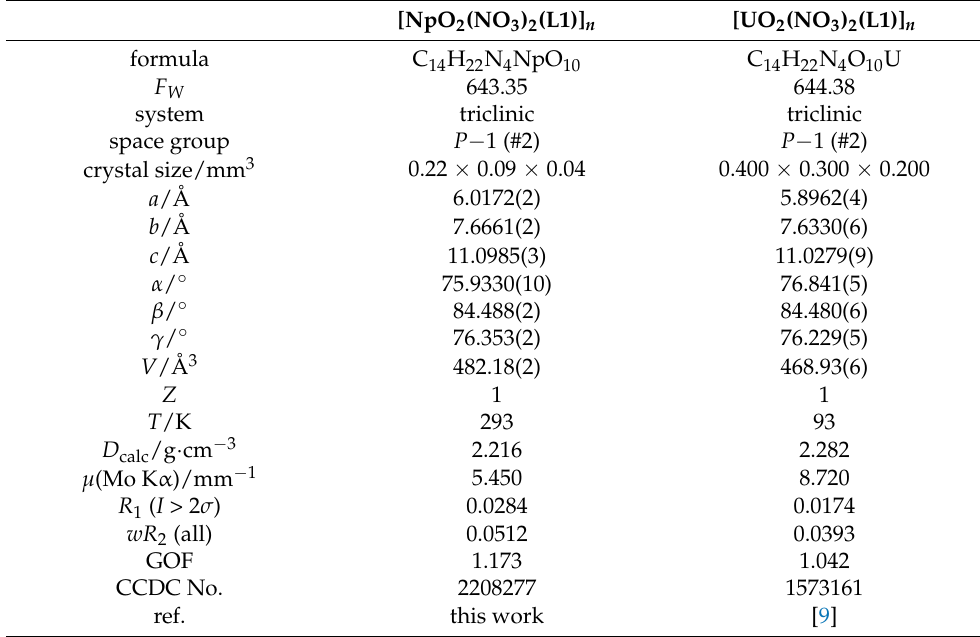
Table 1. Crystallographic data of [AnO 2 (NO 3 ) 2 ( L1 )] n (An = Np,